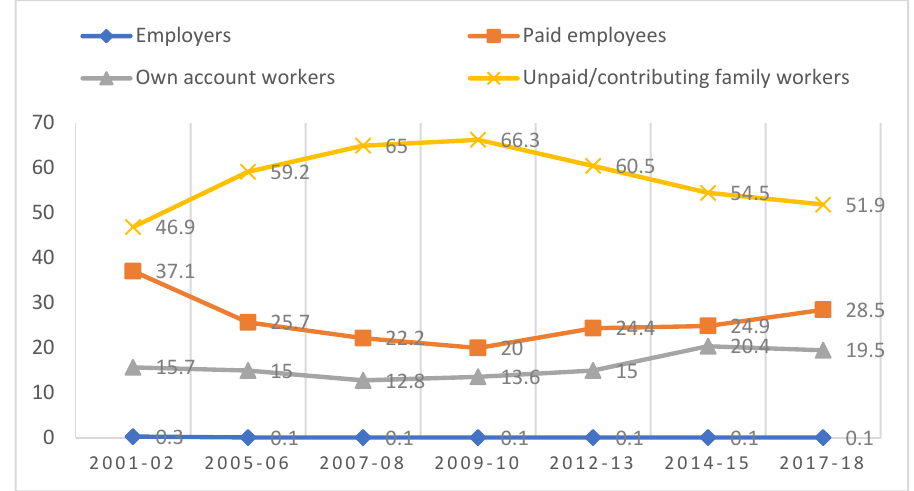
Figure 2. Trends in female employment statuses by LFS survey years. Source: LFS various reports.